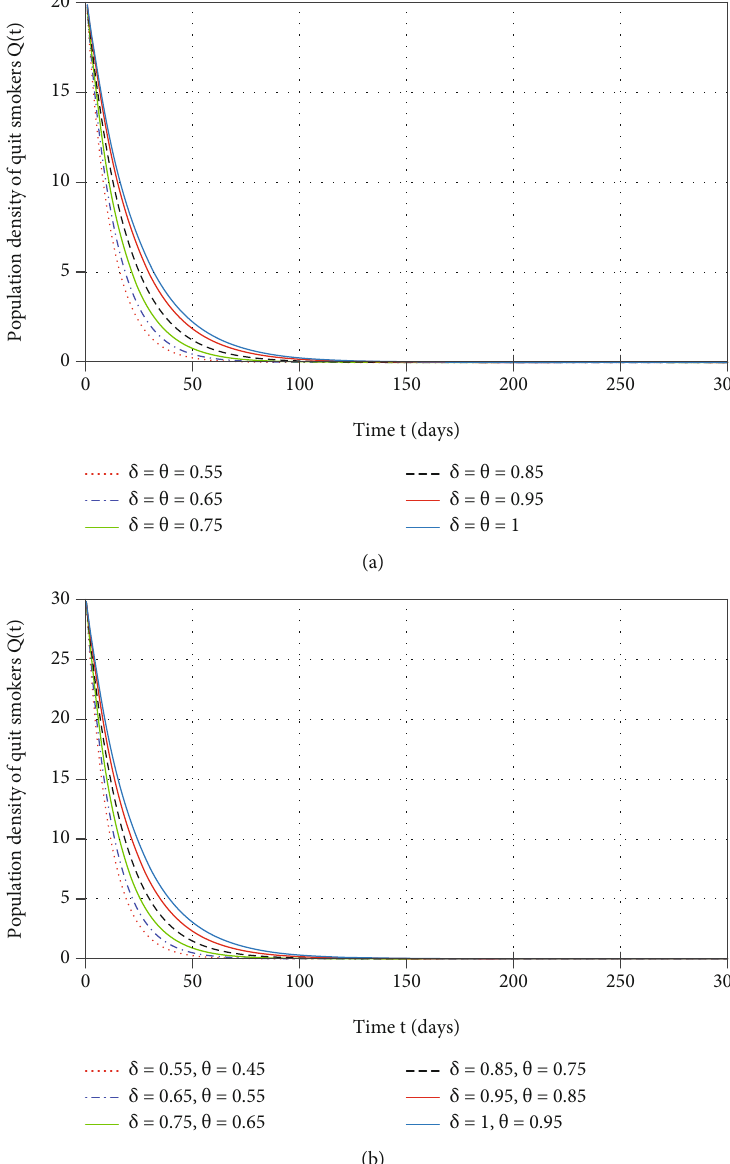
Figure 4: Graphical representation of quit smokers ( Q ð t Þ ) having two di ff erent initial values of L (1) at di ff erent arbitrary fractal dimension and fractional